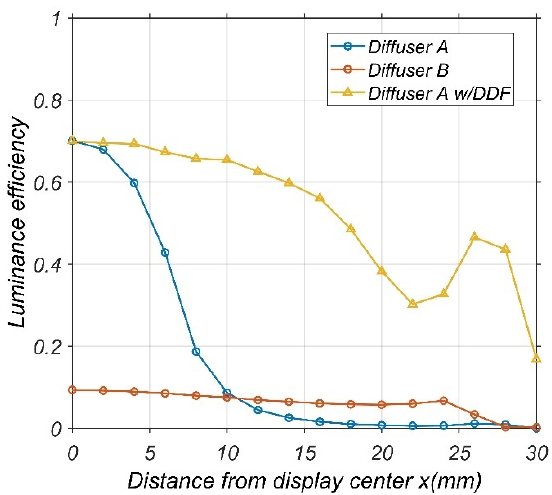
Figure 6. Measured luminous efficiency in the exemplary VR display